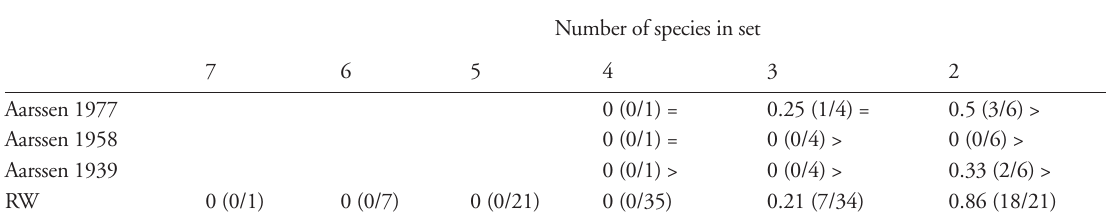
Table 2. Proportion of feasible and stable sets and subsets in published data (feasible and stable sets / number of sets of that size). Stability analysis took place on the competition matrix alone, and may hence be lower still. The Aarssen-data can be compared to the assessment by Wilson and Roxburgh (1992), and the signs ‘>’ and ‘=’ indicate a higher and equal level of stability in their analysis. Data sets for 1977, 1958 and 1939 are from Aarssen (1988). RW refers to Roxburgh and Wilson (2000a). Number of species in